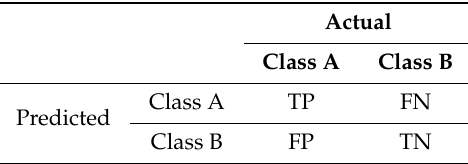
Table 4. Example confusion matrix.